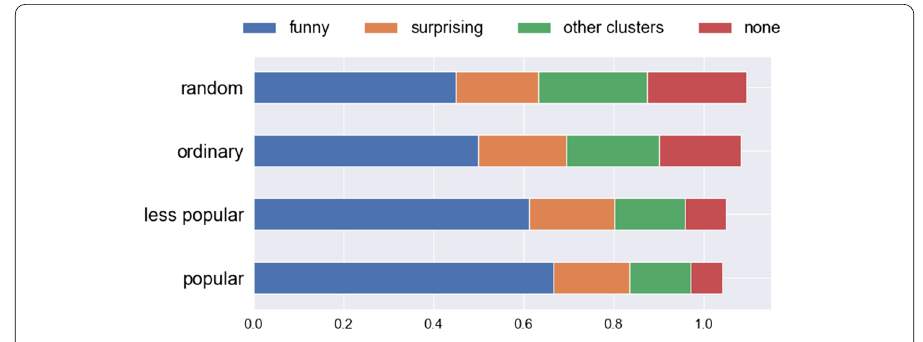
Figure 5 Stacked bar chart with the distribution of clip types with the popularity